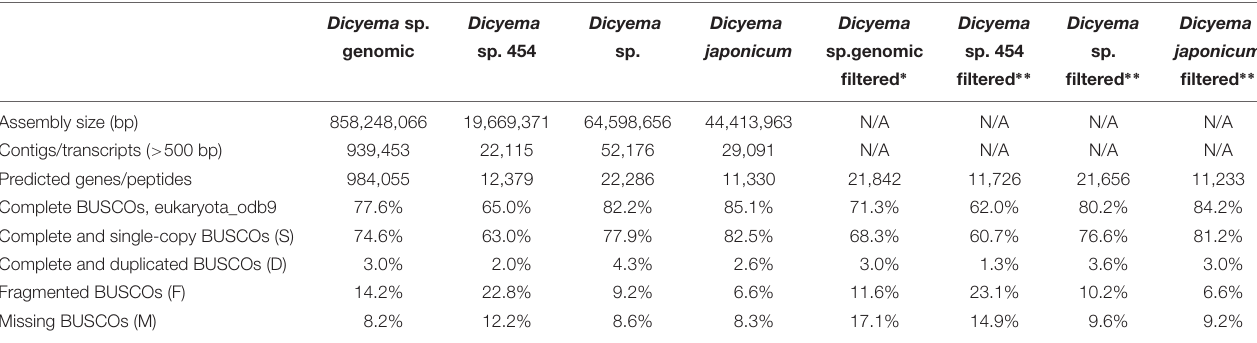
TABLE 1 | Assembly